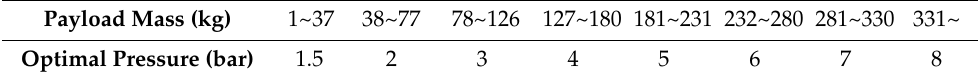
Figure 11. Mass effect simulation under 50 Hz vibration. Table 3. Optimal results between the payload mass and the absolute pressure.